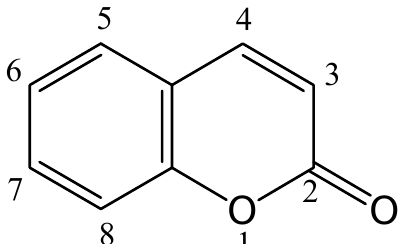
Figure 1 . The chemical structure and numbering scheme of